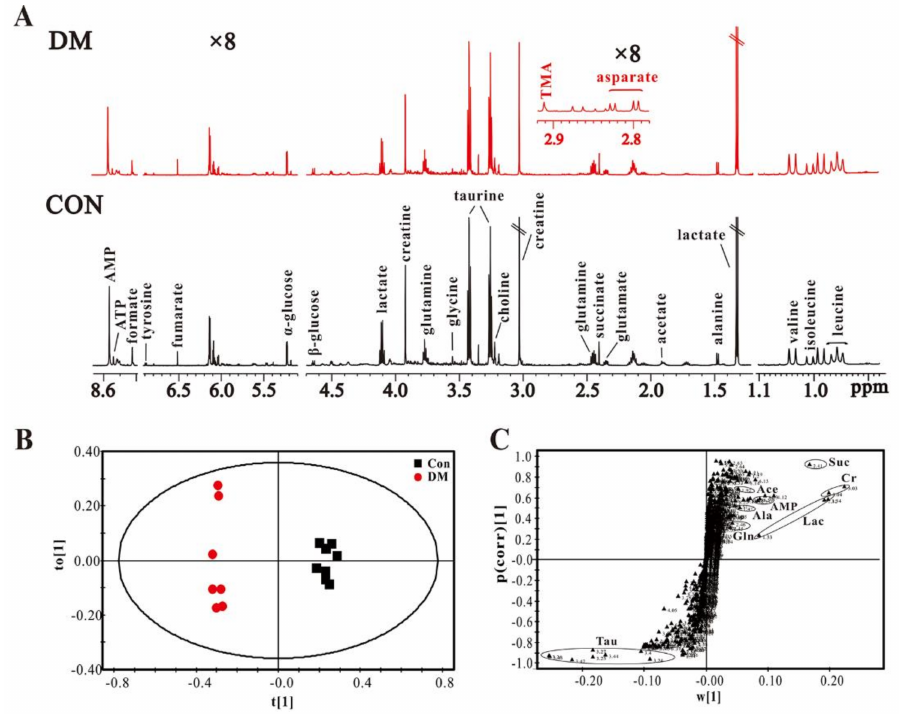
Figure 5. NMR-based cardiac metabolomic analysis: ( A ) typical 600 MHz 1 H-NMR spectra obtained from the heart extracts in STZ-induced diabetic (DM) and normal control (Con) rats; OPLS-DA scores plot ( B) and its corresponding S-plot ( C ) based on the heart metabolic profiles. Metabolite: Tau, taurine; Ace, acetate; AMP, adenosine monophosphate; Ala, alanine; Gln, glutamine; Suc, succinate; Cr, creatine; Lac,